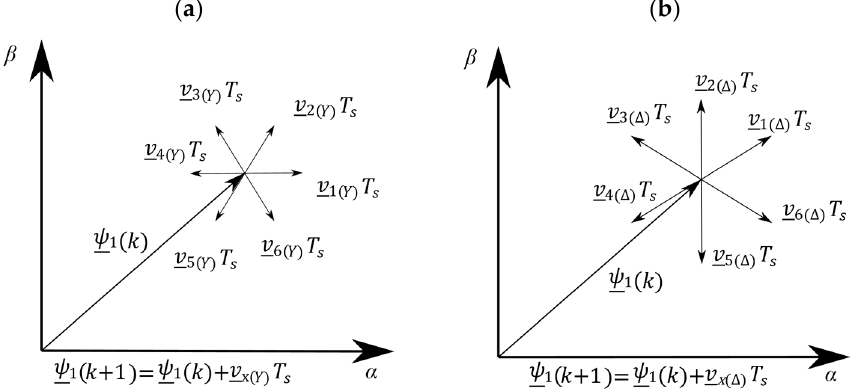
Figure 5. Basic block diagram of the induction motor predictive torque control.